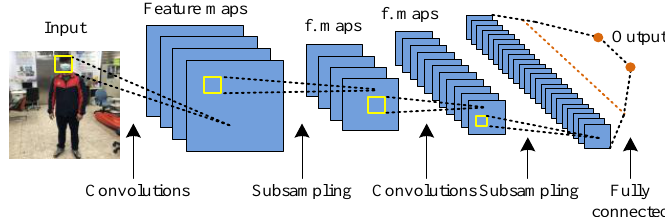
Figure 11. Concept map of CNN.